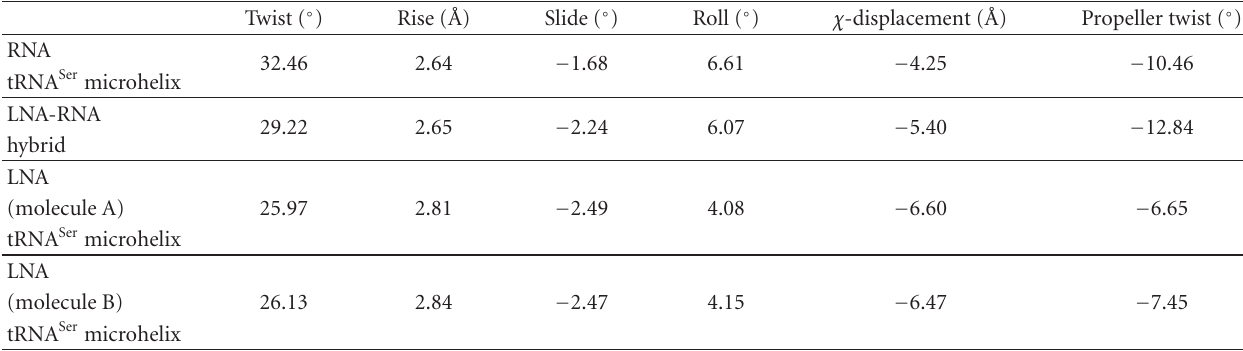
Table 2: Selected overall helical parameters of the tRNA Ser microhelix structure (PDB ID: 3GVN) compared to the LNA-RNA hybrid (PDB ID: 1H0Q) and the LNA helix (PDB ID: 2X2Y). The two LNA molecules correspond to two LNA helices located in the asymmetric unit of the crystal structure.